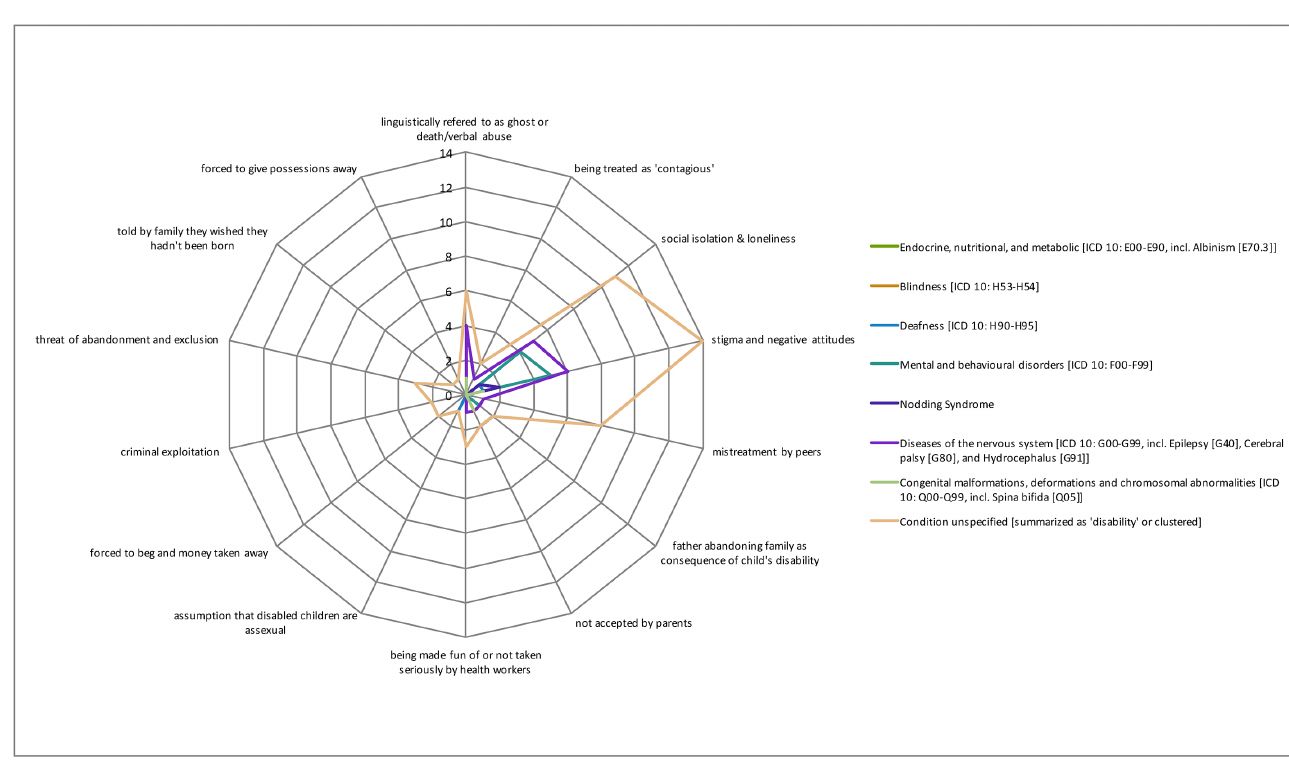
Fig 6. Evidence of psychological abuse by type of disability.